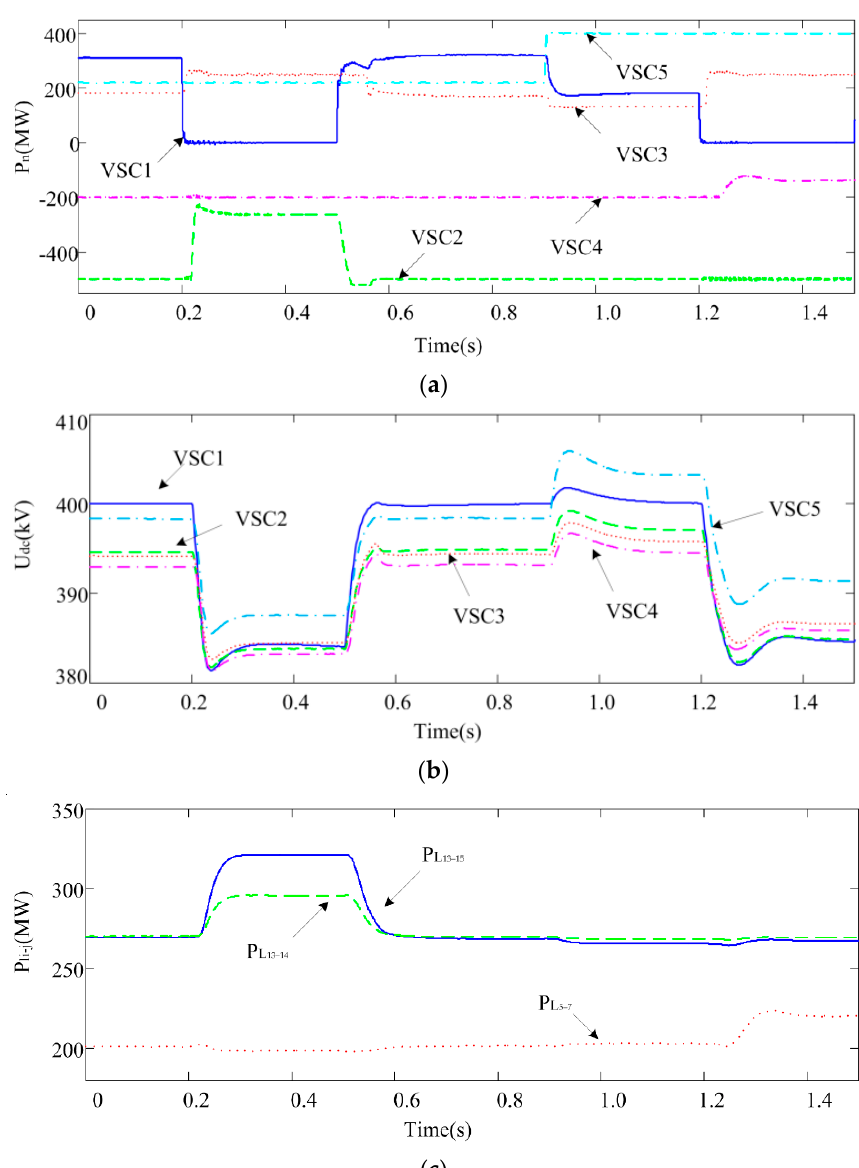
Figure 9. Simulation under priority control mode. ( a ) Active power of converters. ( b ) DC voltage of converters. ( c ) Active power of critical AC lines.